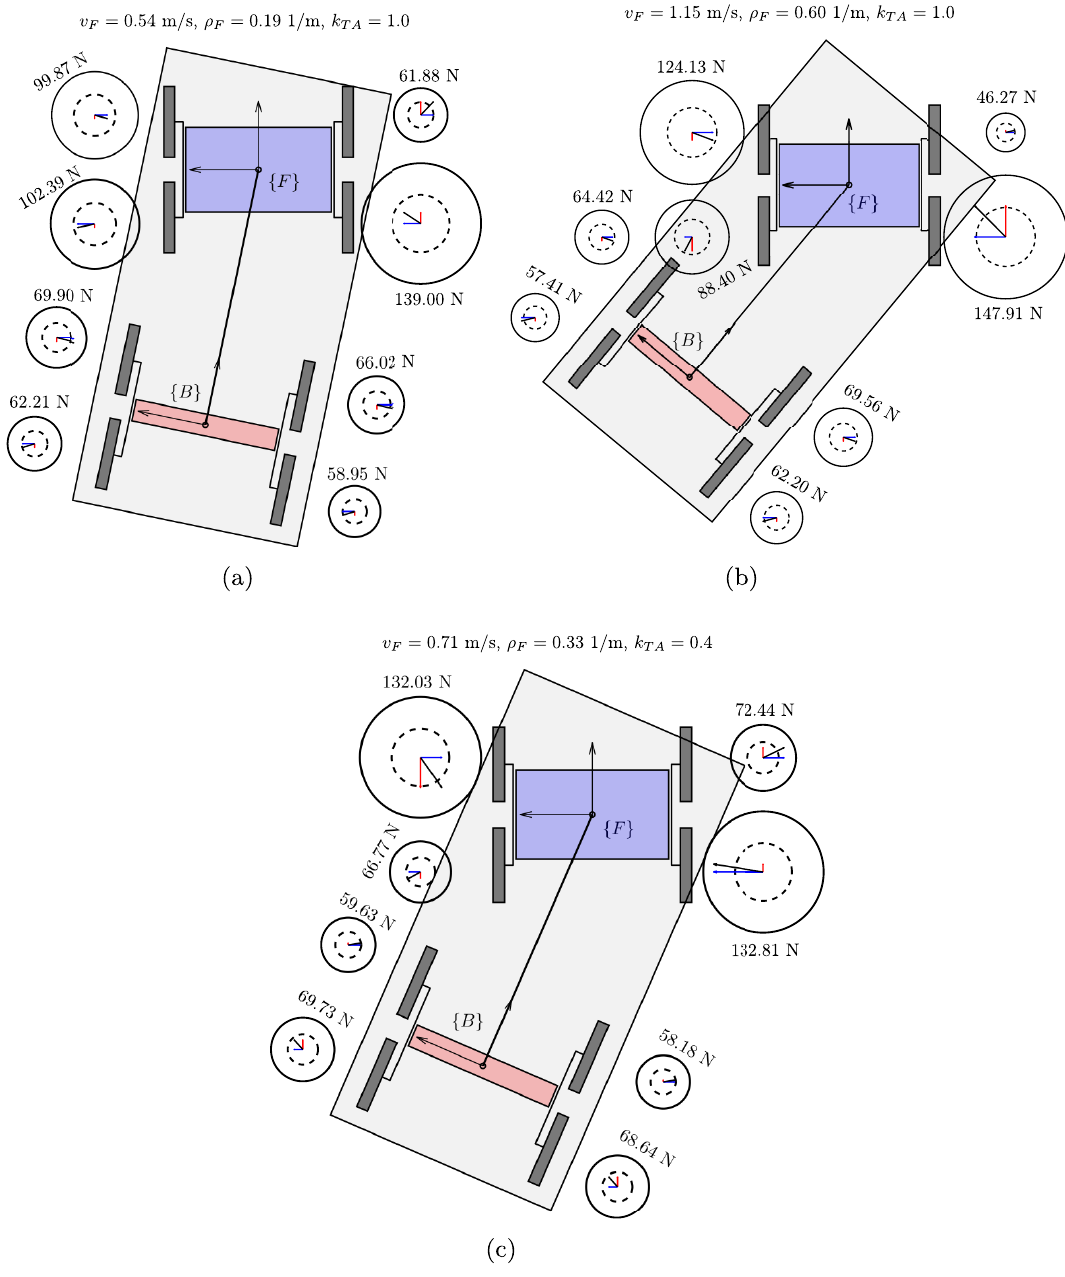
The dashed circles represent instead the magnitude of the force F ∗ = 𝜇 d F n , ⋆ when the tyre saturates due to a large wheel slip. F h , ⋆ , h , ⋆ F F l , ⋆ , and t , ⋆ are represented by the black, red, and blue vectors